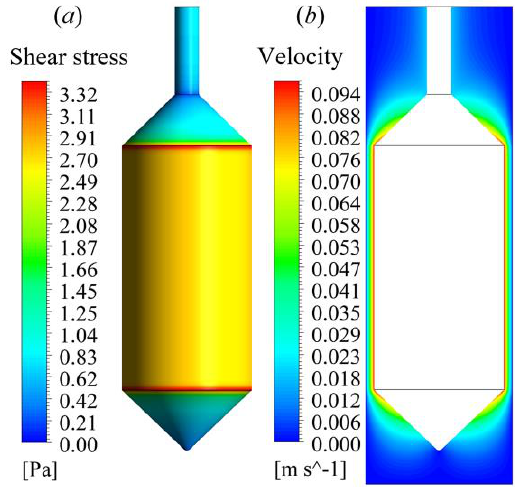
Fig. 9. The oil shear stress τ O contours on the spindle wall ( a ), the velocity v contours in the XY plane ( b